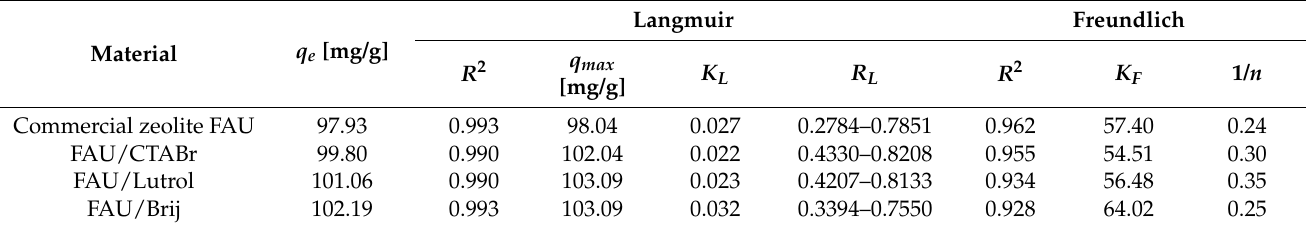
Table 3. Langmuir and Freundlich parameters of the adsorption isotherms of curcumin onto com- mercial zeolite FAU and hierarchical